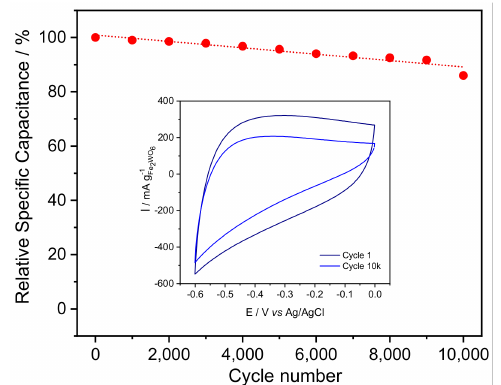
Figure 5. Long term cycling stability for FWO-600 sample at 20 mV s − 1 in 5M LiNO 3 . Inset: cyclic voltammograms at cycle 1 and at cycle